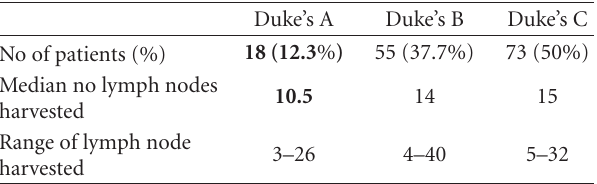
Table 4: Corelation between lymph node harvest and Dukes’ stage (6 patients undergoing radiotherapy Table 2: Relation of lymph node metastasis and T stage. T1 T2